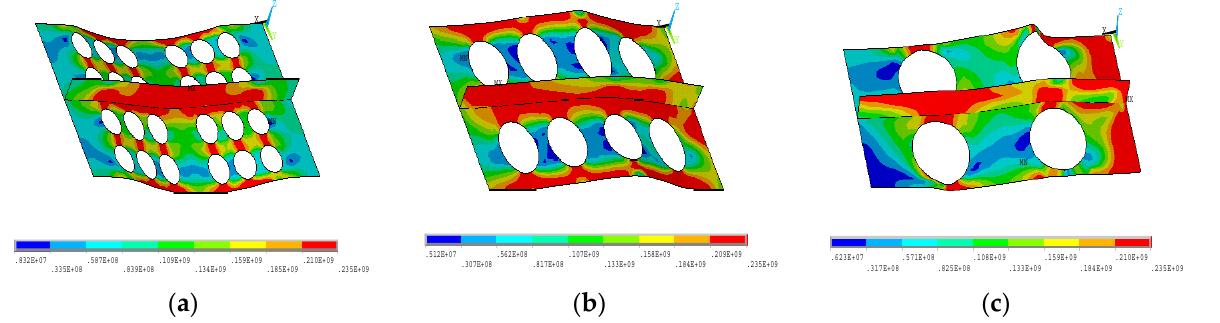
Figure 14. Deformed shape at the ultimate load step: DoO = 28.30% for SP-NS5-2 ( a ), SP-NS6-2 ( b ) and SP-NS7-2 ( c ).